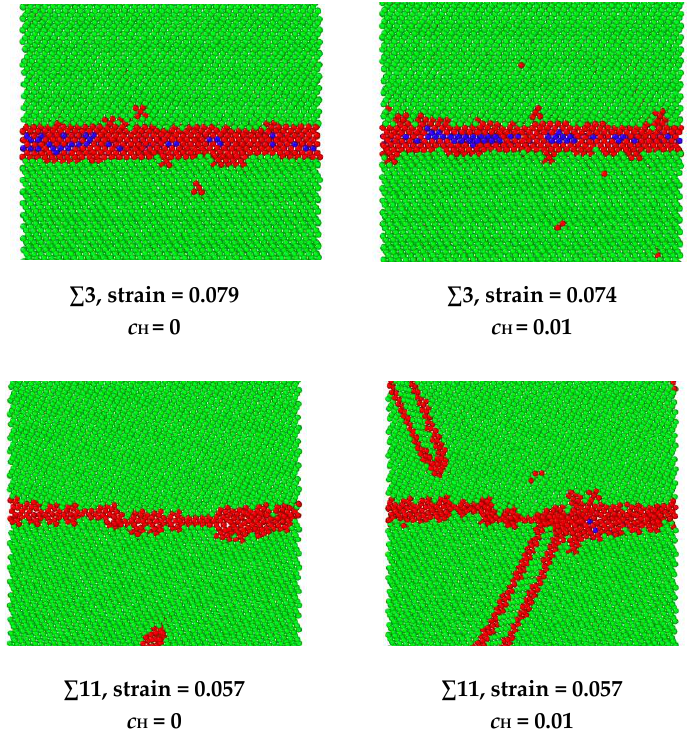
(cid:80) (cid:80) 3 GB and twinning emission strain in 11